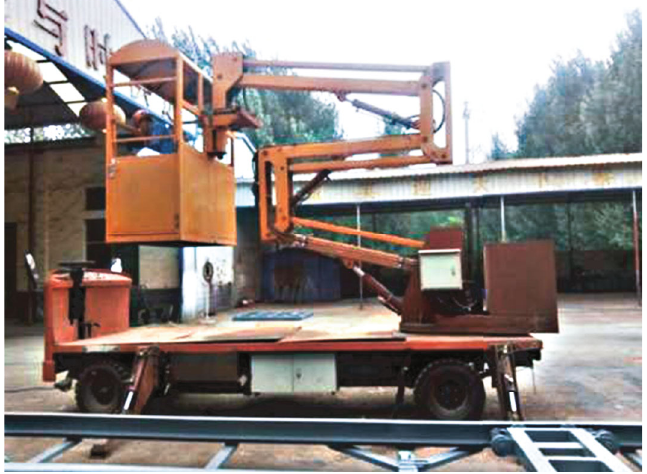
Figure 14: Prototype of aerial working